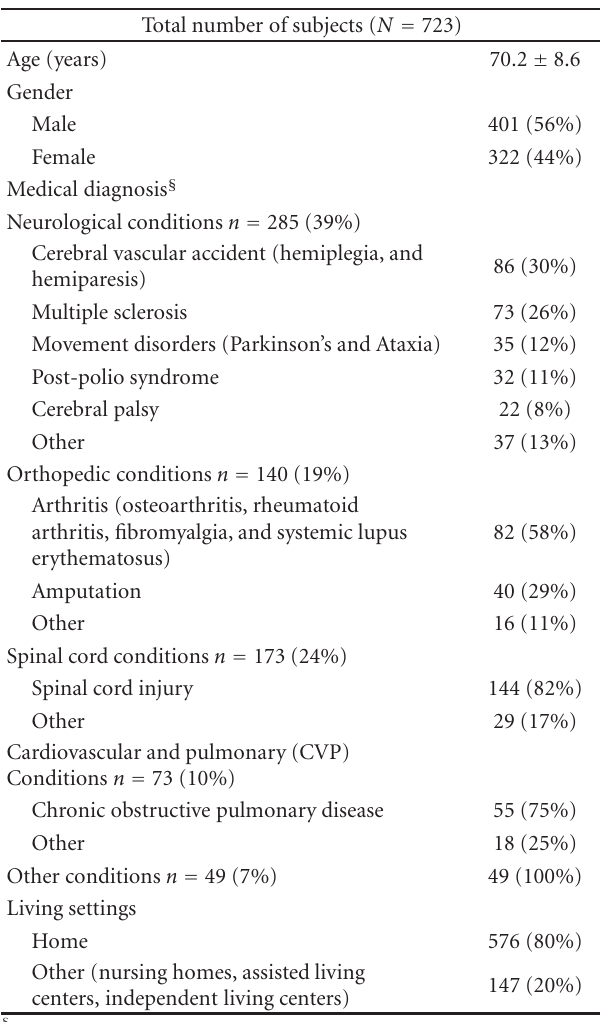
Table 1: Demographic characteristics of the